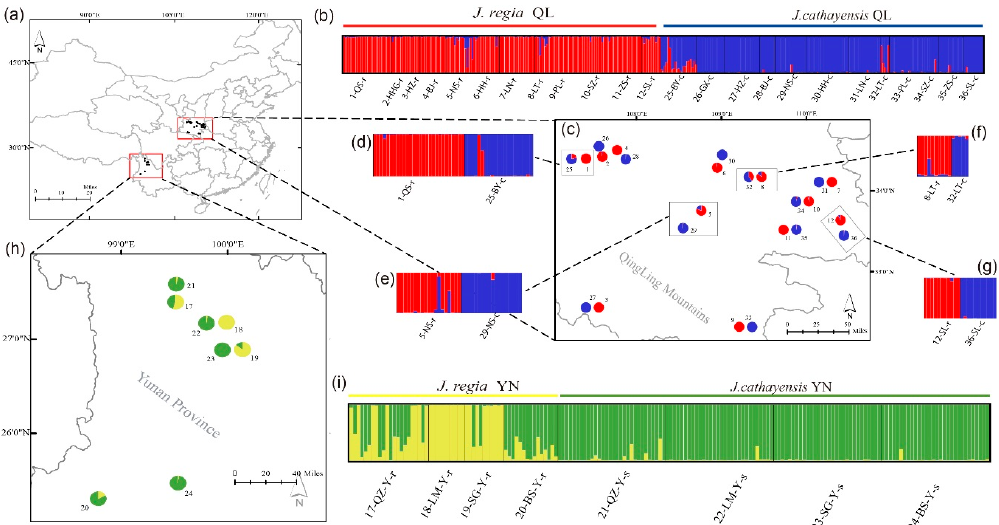
on the EST-SSR datasets. groups based